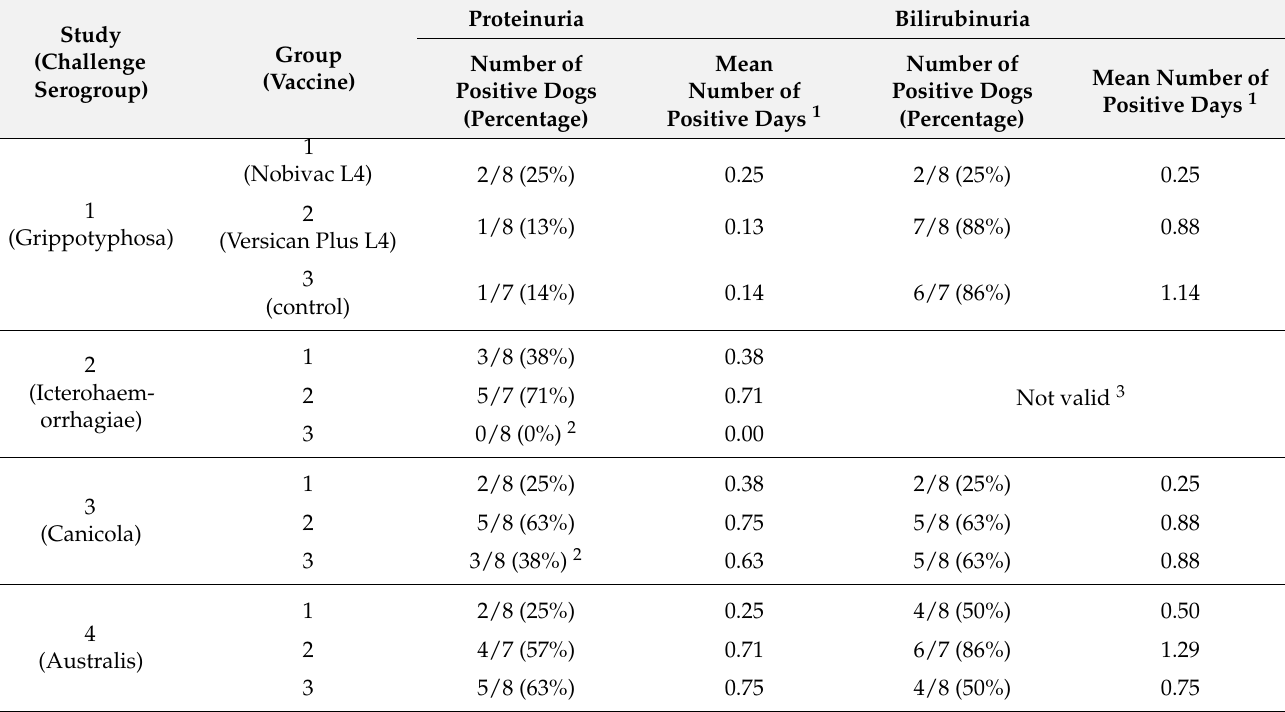
Proteinuria Bilirubinuria